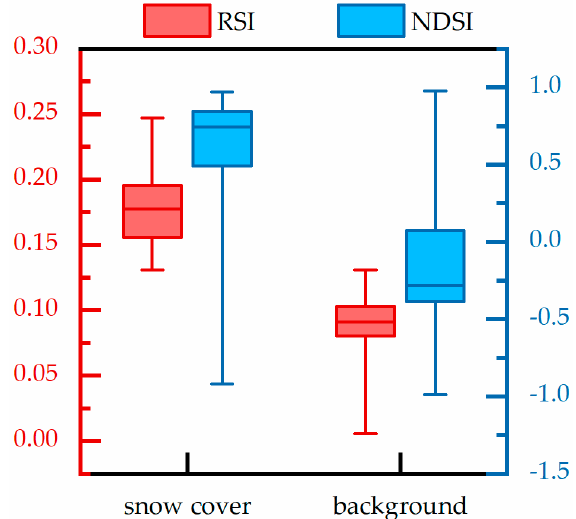
Figure 15. Distributions of the RSI and NDSI values of snow cover and background samples using box and whisker plots. The first and last horizontal lines of each box from top to bottom represent the maximum and minimum, respectively. The second, third, and fourth horizontal lines of each box from top to bottom represent the 25th, 50th (median), and 75th percentiles, respectively.